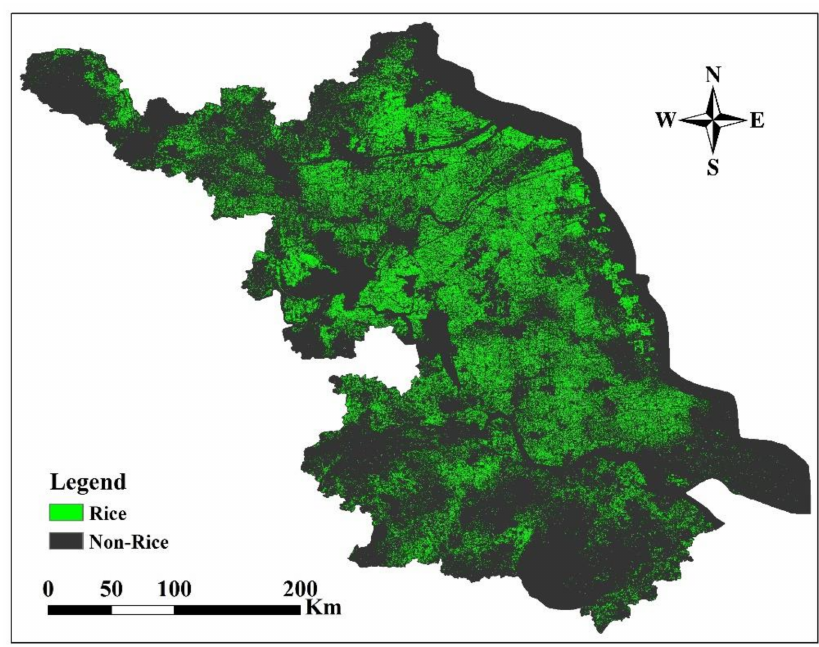
Figure 13. The provincial map of Jiangsu for the rice distribution of 2016 obtained using the OCSVC